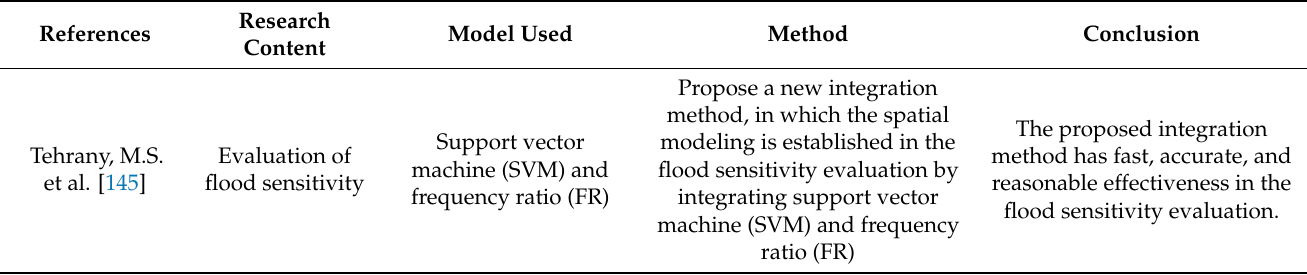
Table 8. Typical cases of machine learning models in landslide disaster